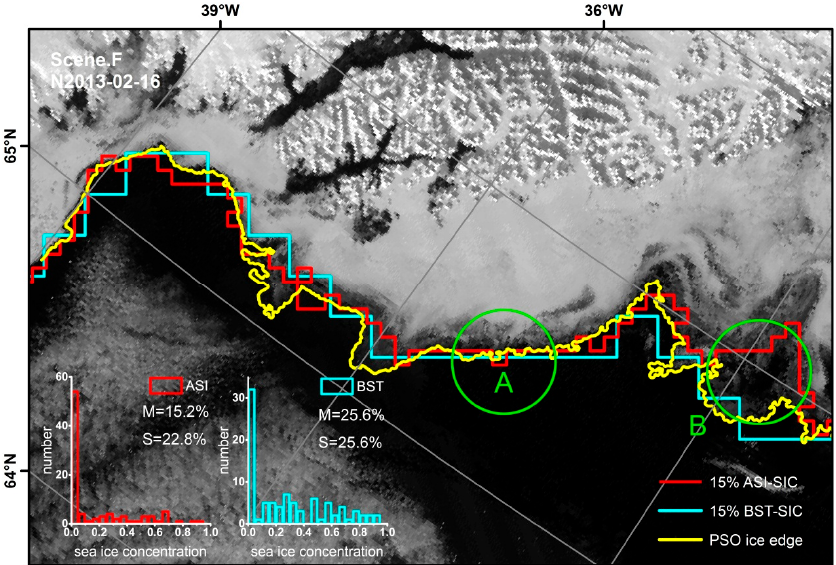
Figure 6. Contour of the 15% ASI ‐ SIC, 15% BST ‐ SIC and the PSO ice edge overlaid on the MOD09GA, for the Arctic at 16 February 2014. for the Arctic at 16 February